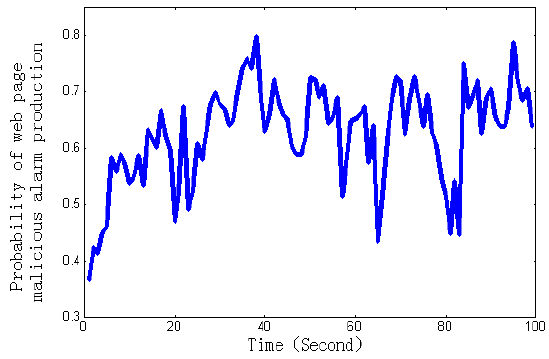
Fig. 11. The probability of Malicious VBScript script alarm